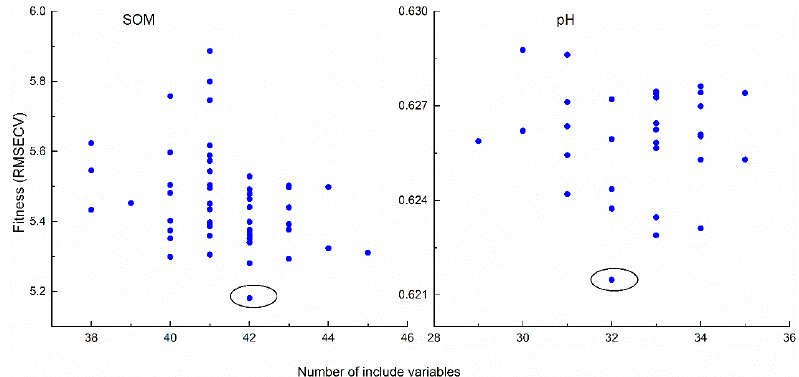
Figure 4. Fitness (RMSECV) versus number of variables used by each individual from genetic algorithm (GA) 10 times.